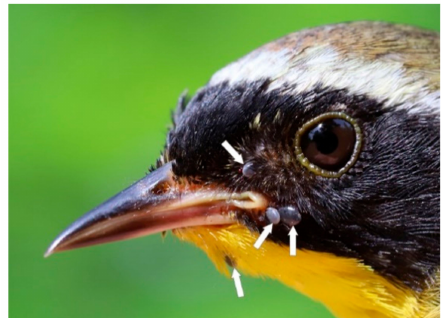
Figure 2. Common Yellowthroat, after-second year male, infested with 12 I. scapularis nymphs (eight not visible). This multi-tick bird parasitism brings to light the potential of this bird, and the attached nymphs, to establish a new population of blacklegged ticks. Photo credits: Ana